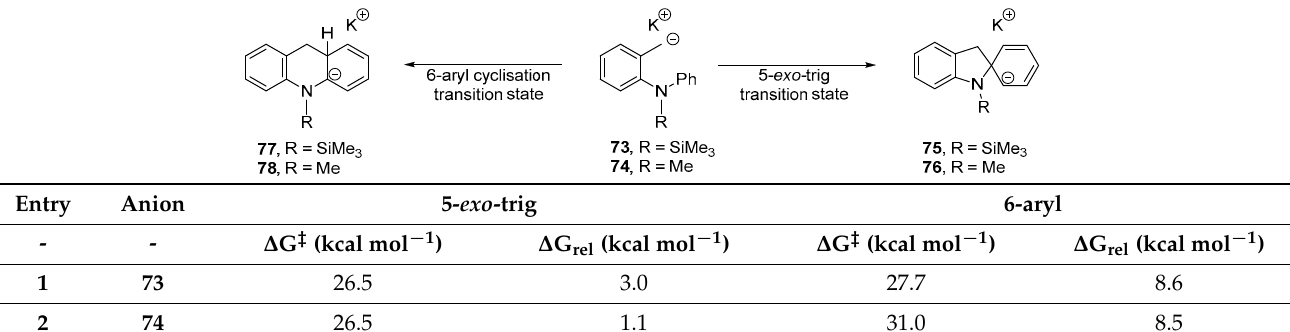
Table 2. Summary of activation energies and relative changes in Gibbs free energy for the cyclisation step of the anionic mechanisms for anions 73 and 74 .